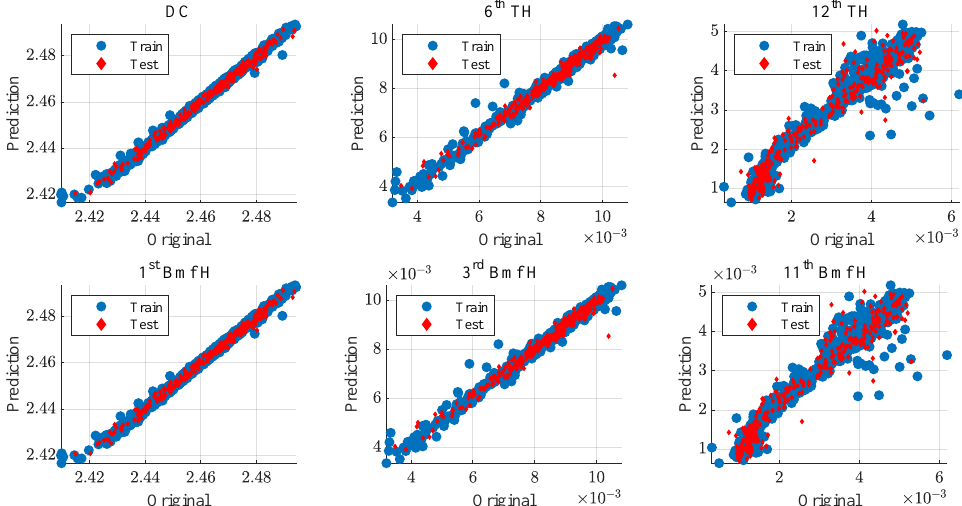
Figure 7. GPR 1000 samples accuracy. Predicted vs. original values for the DC, 6th and 12th torque and 1st, 3rd and 11th back emf harmonics